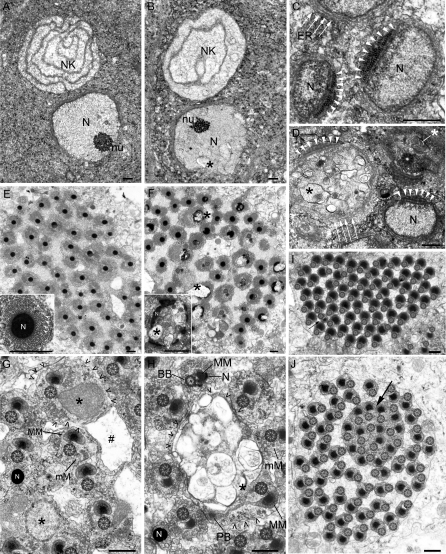
Abnormal Nuclear Transformation of the Y-Bearing SpermUltrastructural studies of sperm nuclear transformation and individualization in wild-type simB Nmy males (A, C, E, G, I) as compared with SSR12-2-7 nmy males (B, D, F, H, J) at 16 °C. All scale bars represent 500 nm.(A and B) Onion stage. The earliest abnormalities are detected as nucleoplasmic vacuoles (*) at the onion stage in the nuclei (N) of nmy (B) but not of Nmy (A) males. The grainy protein body, likely the nucleolus (nu) and the spherical nebenkern (NK), appear to be normal.(C and D) Elongation period. Normally, the nucleoplasm (N) is homogenous, and several rows of microtubules are aligned along the fenestrated portion of the nuclear membrane (arrowheads). A sheath of endoplasmic reticulum (ER) surrounds the nucleus (arrow). In nmy males, some nuclei at this stage have very pronounced nucleoplasmic vacuoles (*), as if the elimination of excess nucleoplasm through the fenestrated side has failed, although the alignment of microtubules is apparently normal (arrowheads, D). On the other hand, some nuclei appear normal, and show a reduced volume compared to the abnormal nuclei (N in D), suggesting some nucleoplasm has already been eliminated.(E and F) Post-elongation period. By the end of this period, the chromatin has been homogeneously condensed and most of the nuclear envelope has been eliminated (E). Meanwhile, arrays of microtubules (arrowheads in lower left insert) have become rigidly organized around the nuclei. However, the nuclear condensation process has been disrupted in many nmy nuclei, in which the nucleoplasmic vacuoles apparently block the condensation progress (* for examples shown in F). Note that nuclear condensation is always accompanied by apposed rows of microtubules (arrowheads in lower left insert of F), lack of which seems to correspond to failed chromatin condensation and the subsequent rupture of nuclear envelope nearby.(G–J) Individualization process. A cystic bulge is initiated at the head region and traverses through the entire length of the spermatid cyst. During this process, excess nucleoplasm, nuclear envelope, and syncytial bridges between spermatids are squeezed away into the waste bag (G). In a cross section through the cystic bulge near the head region, fenestrated (*), and nonfenestrated (#) nuclear envelopes are seen in the process of elimination. One axonemal complex is marked with “v”. For the nuclear head (N in G) that the cystic bulge has already passed, note the absence of surrounding microtubules. (I) In this cross section through the tail region after individualization, 62 spermatid tails are each invested in its own membrane and well separated. One abnormal tail is also seen (arrow). The other three of the 64 tails may have already been eliminated into the waste bag. (H) Nucleoplasmic vacuoles (*) within an abnormal spermatid are squeezed into the tail region, apparently causing physical difficulty for the cystic bulge to pass through. This may explain why individualization cannot proceed through for a cluster of 13 tails (arrow in J), while the other 46 tails appear normal. The other five of the 64 tails were probably eliminated into the waste bag. Also shown in (G) and (H) are some notable structural components within an axonemal complex including basal body (BB), major mitochondrial derivative (MM), minor mitochondrial derivative (mM), and paracrystalline body (PB).